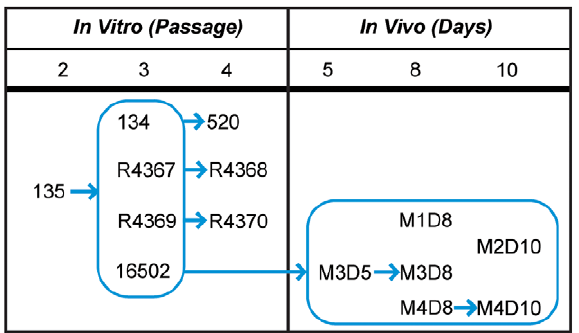
Figure 1. EBOV-Kik sample history is modeled here over passaging and infection time. Arrows indicate parent child relationship of the isolates and infections (e.g., M1D8 was derived by infecting an NHP with passage 3 stock 16502 which was derived from passage 2 stock 135). All passage 3 virus were obtained from 135. Passage 4 virus were derived from the preceding stocks (indicated by an arrow). All ‘‘in vivo’’ samples were derived after infection with viral stock 16502. Where multiple days were available from the same animal an arrow describes the progression of samples.